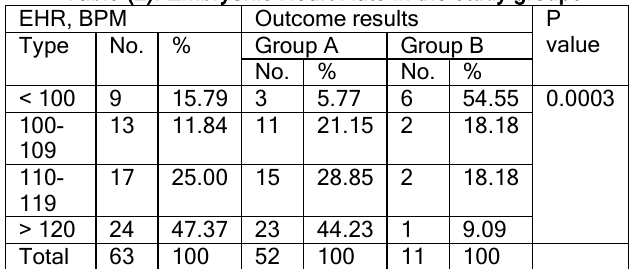
Table (2): Embryonic Heart Rate in the study groups